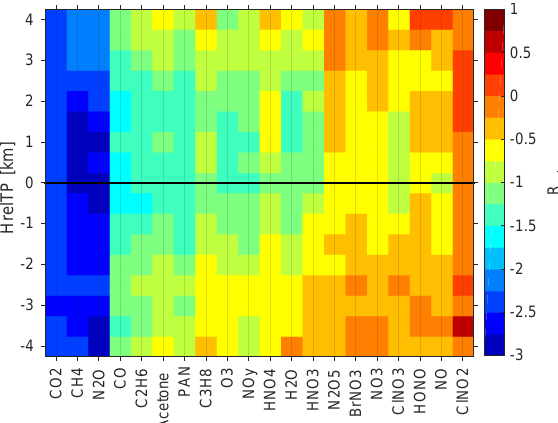
Figure 7. R var calculated according to Eq. (5) for a timescale of 1 year for all species in all height bins, using MOD regular MOD RANDPATH . Low values indicate small differences in variabil- ity.